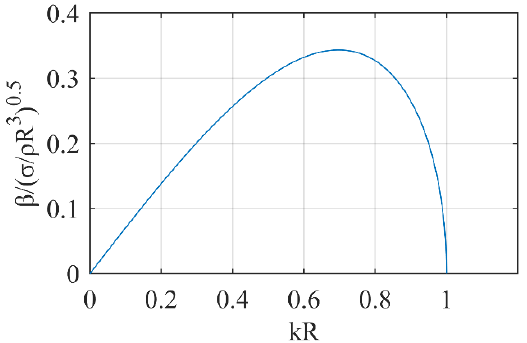
Figure 5. Variation of surface wave growth rate with wave number.